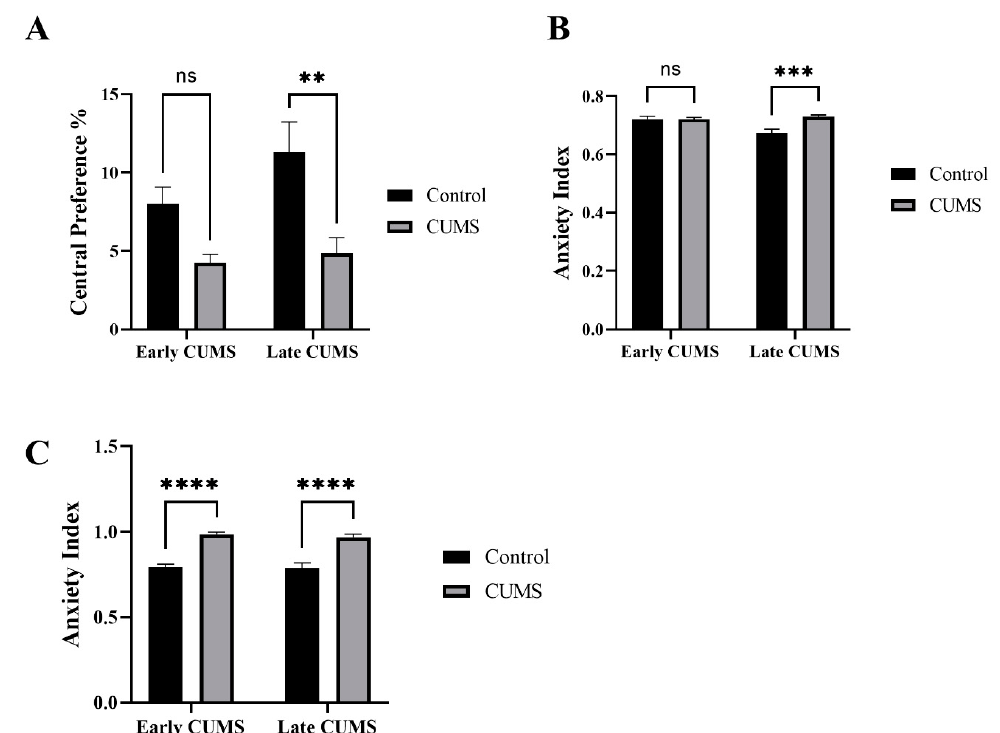
Figure 4. The effect of early and late CUMS on anxiety in ( A ) central preference percentage, ( B ) EZM, and ( C ) EPM. Two-way ANOVA was used, followed by Šídák’s multiple-comparisons test. (**) indicates a significant difference between the CUMS groups and the control group at p < 0.01, *** p < 0.001, and **** p < 0.0001. ns: not significant.